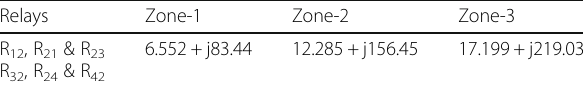
Table 1 Zone settings of the distance relays Relays